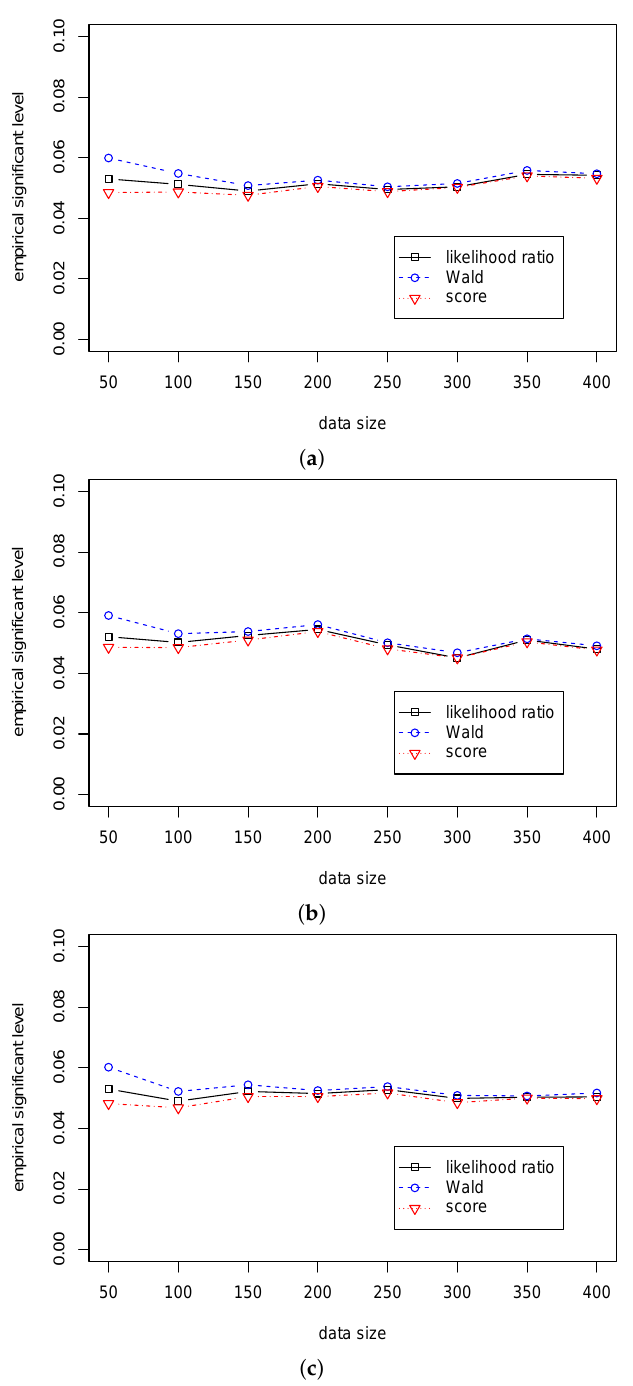
Figure 1. The empirical levels of three test statistics ( T L , T W , T S ) for testing H 0 : β 1 = 0 in Case (A2) for different α . ( a ) The empirical level with H 0 : β = ( 1,0 ) (cid:62) for α = 0.75; ( b ) The empirical level with H 0 : β = ( 1,0 ) (cid:62) for α = 0.85; ( c ) The empirical level with H 0 : β = ( 1,0 ) (cid:62) for α =